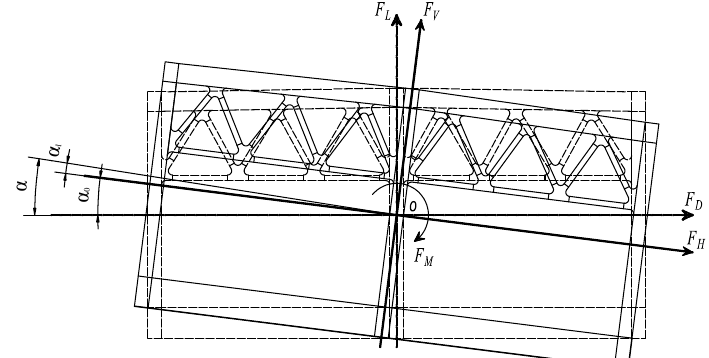
Figure 6. Three components of the wind load along different axes.